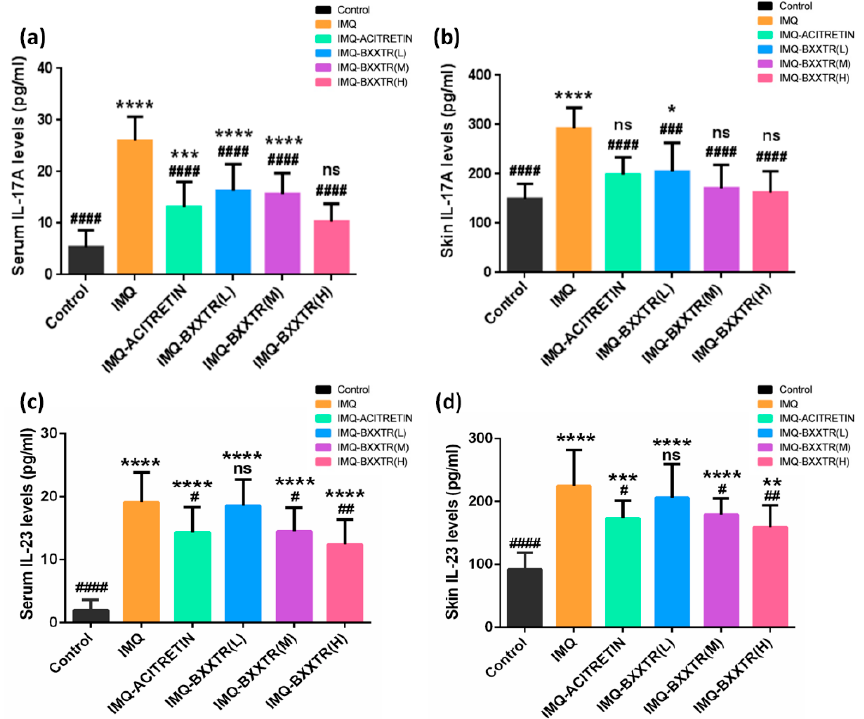
Figure 5. Effect of BXXTR on IMQ-induced changes in protein levels of IL-17A and IL-23 in the back skin and serum of BALB/c mice. ( a ) IL-17A protein levels in serum; ( b ) IL-17A protein levels in the back skin; ( c ) IL-23 protein levels in serum; ( d ) IL-23 protein levels in the back skin. IL-17A and IL-23 were measured using standard ELISA kits. Values are expressed as mean ± SD ( n = 10 for each group). Column with * or # above manifests a significant difference between groups ( p < 0.05) and “ns” means no significant difference. * p < 0.05, ** p < 0.01, *** p < 0.001, **** p < 0.0001, # p < 0.05, ## p < 0.01, ### p < 0.001, #### p < 0.0001.